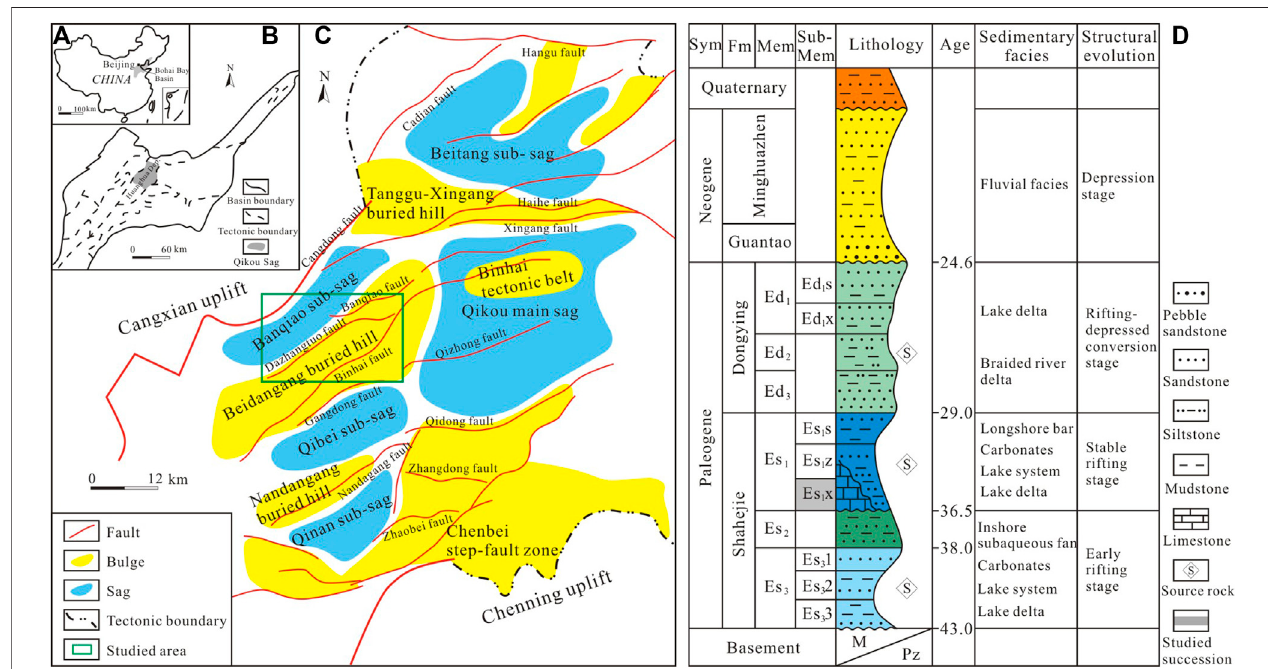
FIGURE 4 | Regional geological map and stratigraphic comprehensive histogram of the Qikou Sag, Bohai Bay Basin. (A) Location of the Bohai Bay Basin. (B) Location of the Huanghua Depression. (C) Geological map of the Qikou Sag. (D) Stratigraphic histogram of the Qikou Sag. Sym = system, Fm = formation, Mem = member, Sub-Mem = sub-member (modi fi ed from Huang et al., 2012; Song et al., 2022).